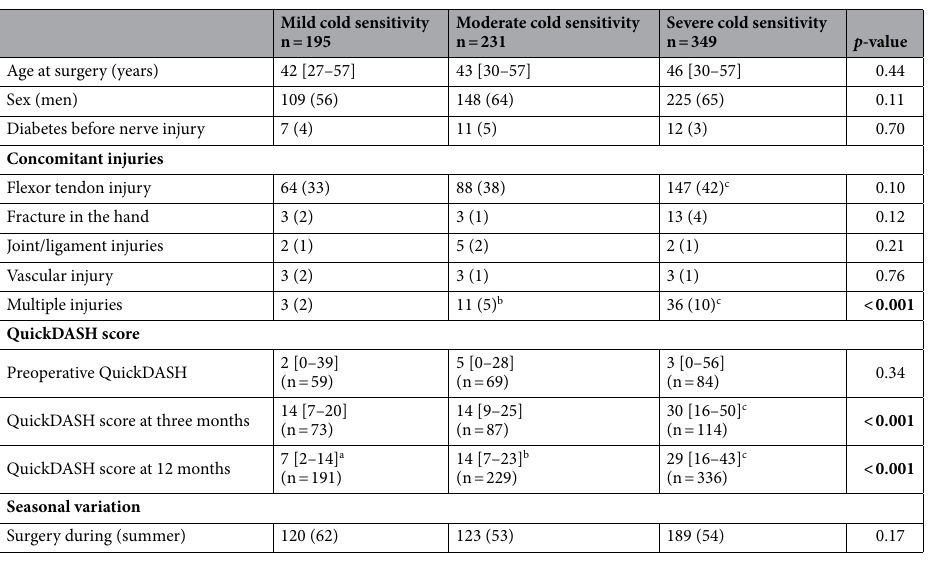
Table 5. Characteristics and QuickDASH results in cases with mild (cold sensitivity symptom scoring ≤ 30), moderate (cold sensitivity symptom scoring 31–70) and severe (cold sensitivity symptom scoring > 70) cold sensitivity at 12 months postoperatively treated with direct suture of a digital nerve injury [39]. Values are presented as n (%) or median [IQR; interquartile range]. Bold values indicate p -value < 0.05. Significance testing with Kruskal Wallis and post-hoc Mann–Whitney U-test for continuous variables, and Chi Square for nominal variables, where a indicates p < 0.05 between mild and moderate; b indicates p < 0.05 between moderate and severe; c indicates p < 0.05 between mild and